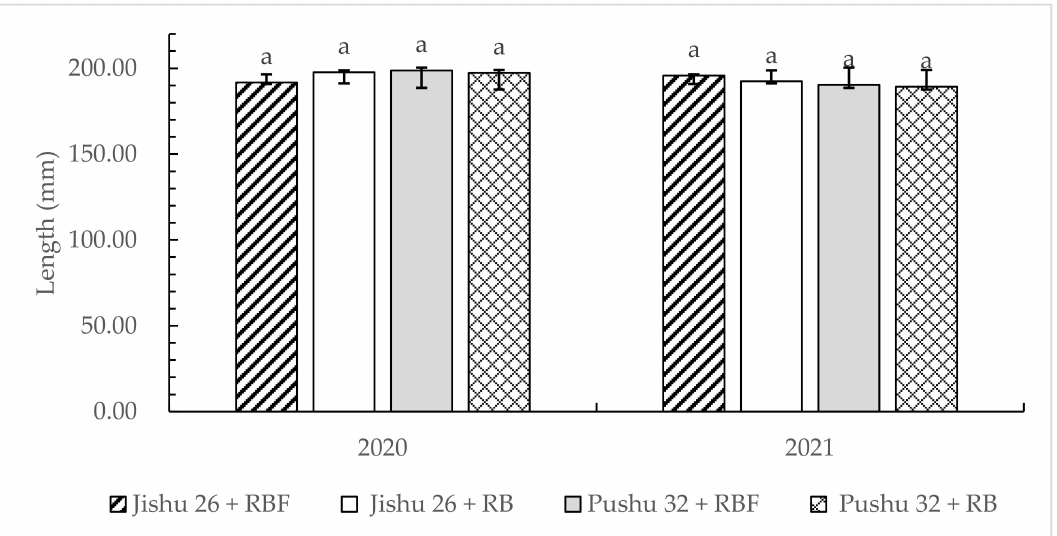
Figure 13. Length of sweet potato slips under the soil after transplanting by the 2CGFS-2 compound sweet potato transplanter under the four treatments in 2020 and 2021. Note: Values with the same letters within each cropping year were not significantly different at p =